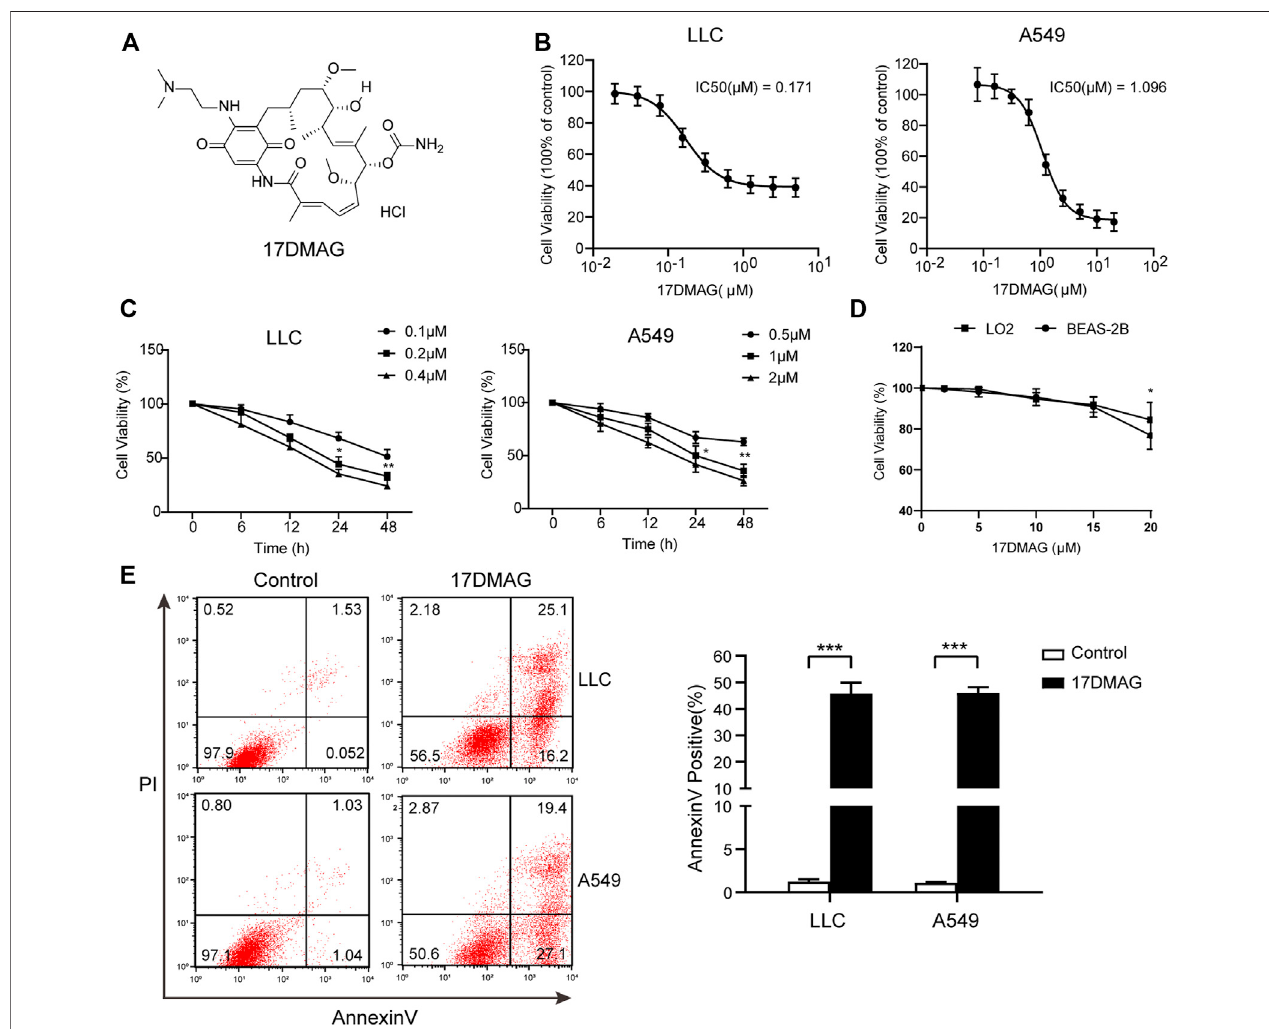
FIGURE 4 | 17-DMAG inhibited lung cancer proliferation and induced cell apoptosis. (A) Molecular structural formula of 17-DMAG. (B) LLC and A549 lung cancer cells weretreated withfolded diluted 17-DMAG. Cell viabilitywasdeterminedbytheMTS method. The IC50 valuewasdeterminedtoevaluatethe inhibition oftumor cell growth by 17-DMAG. The value ofeach cell was the mean value of three independent experiments. (C) Time-course analysis of thegrowth inhibition effect of17-DMAG in LLC and A549 cells. (D) BEAS-2B cells were treated with 17-DMAG at indicated concentrations for 24 h. The cell viability was determined by an MTS assay ( n (cid:1) 5). (E) LLC and A549 cells were treated with 0.2 or 1 μ M 17-DMAG and then stained with PI and AnnexinV-FITC to detect apoptosis by fl ow cytometry. The columns showed the statistical FACS results of three independent experiments. *** p <